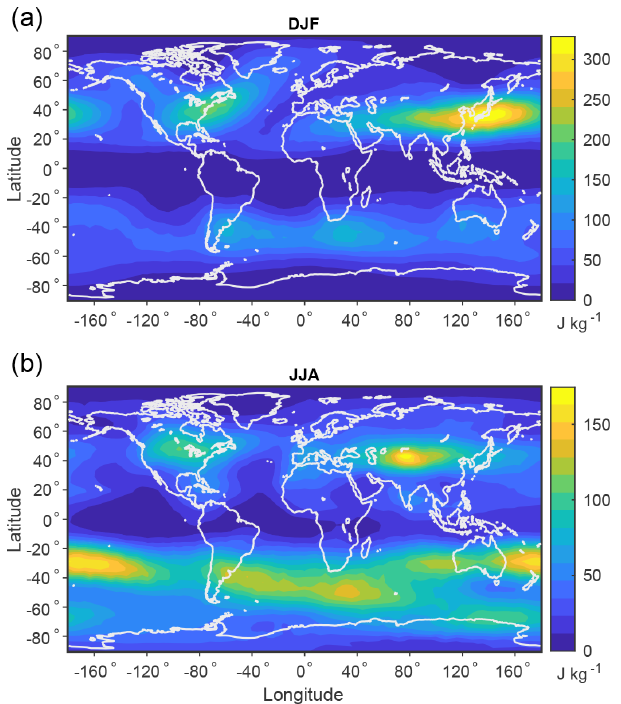
Figure 4. Maximum potential ascent in the local MAPE calculation based on the climatological mean over 1979–2018 for (a) DJF and (b) JJA. MAPE is calculated as in Fig. 3, and the maximum poten- tial ascent is calculated at each surface location as the maximum difference between pressure and reference pressure for any parcel in the column at that location over all the MAPE calculations that include that